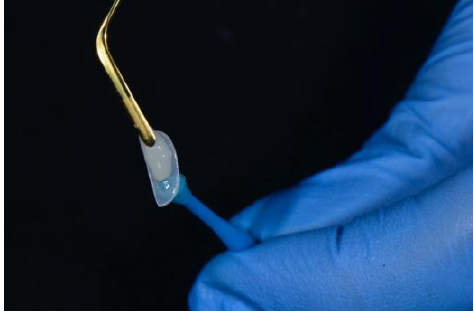
Figure 7. Sectional veneer loaded with enamel shade.